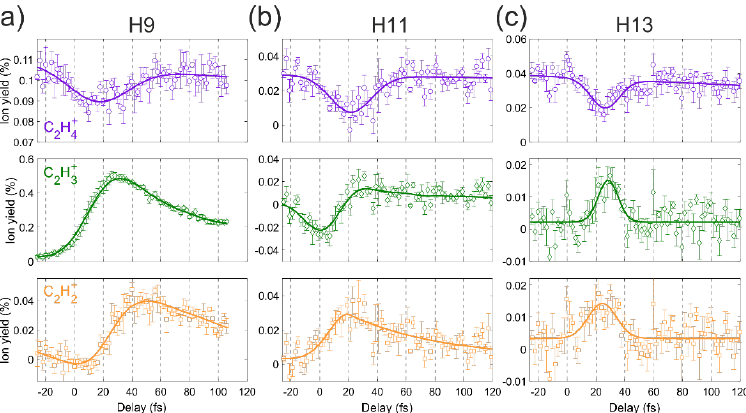
Fig. 2. Delay-dependent IR-induced relative change of the ion yields for C 2 H 4+ (violet circles), C 2 H 3+ (green diamonds) and C 2 H 2+ (orange squares). (a)-(c) excitation with H9, H11 and H13, respectively. The error bars represent the error of the mean obtained by summing 4 independent scans for each ion yield. The solid lines are a guide for the eye. In conclusion, the combination of selective excitation and high time resolution allowed us to disentangle the complex dynamics that follow photoexcitation of ethylene and shed new light onto the internal relaxation process of small organic